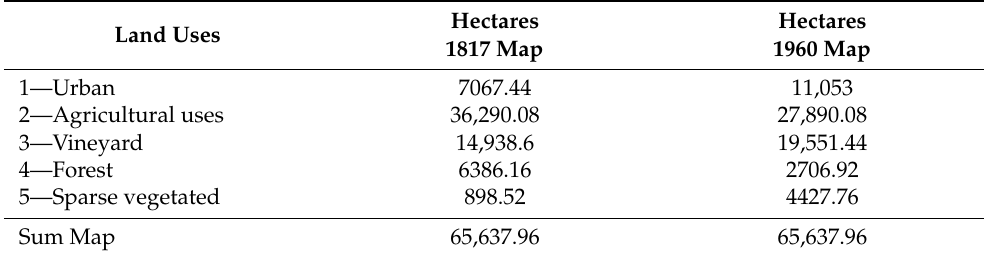
Table 10. Land uses in 1817 and 1960 maps, inside the perimeter of urban areas in the 2009 map (hectares).